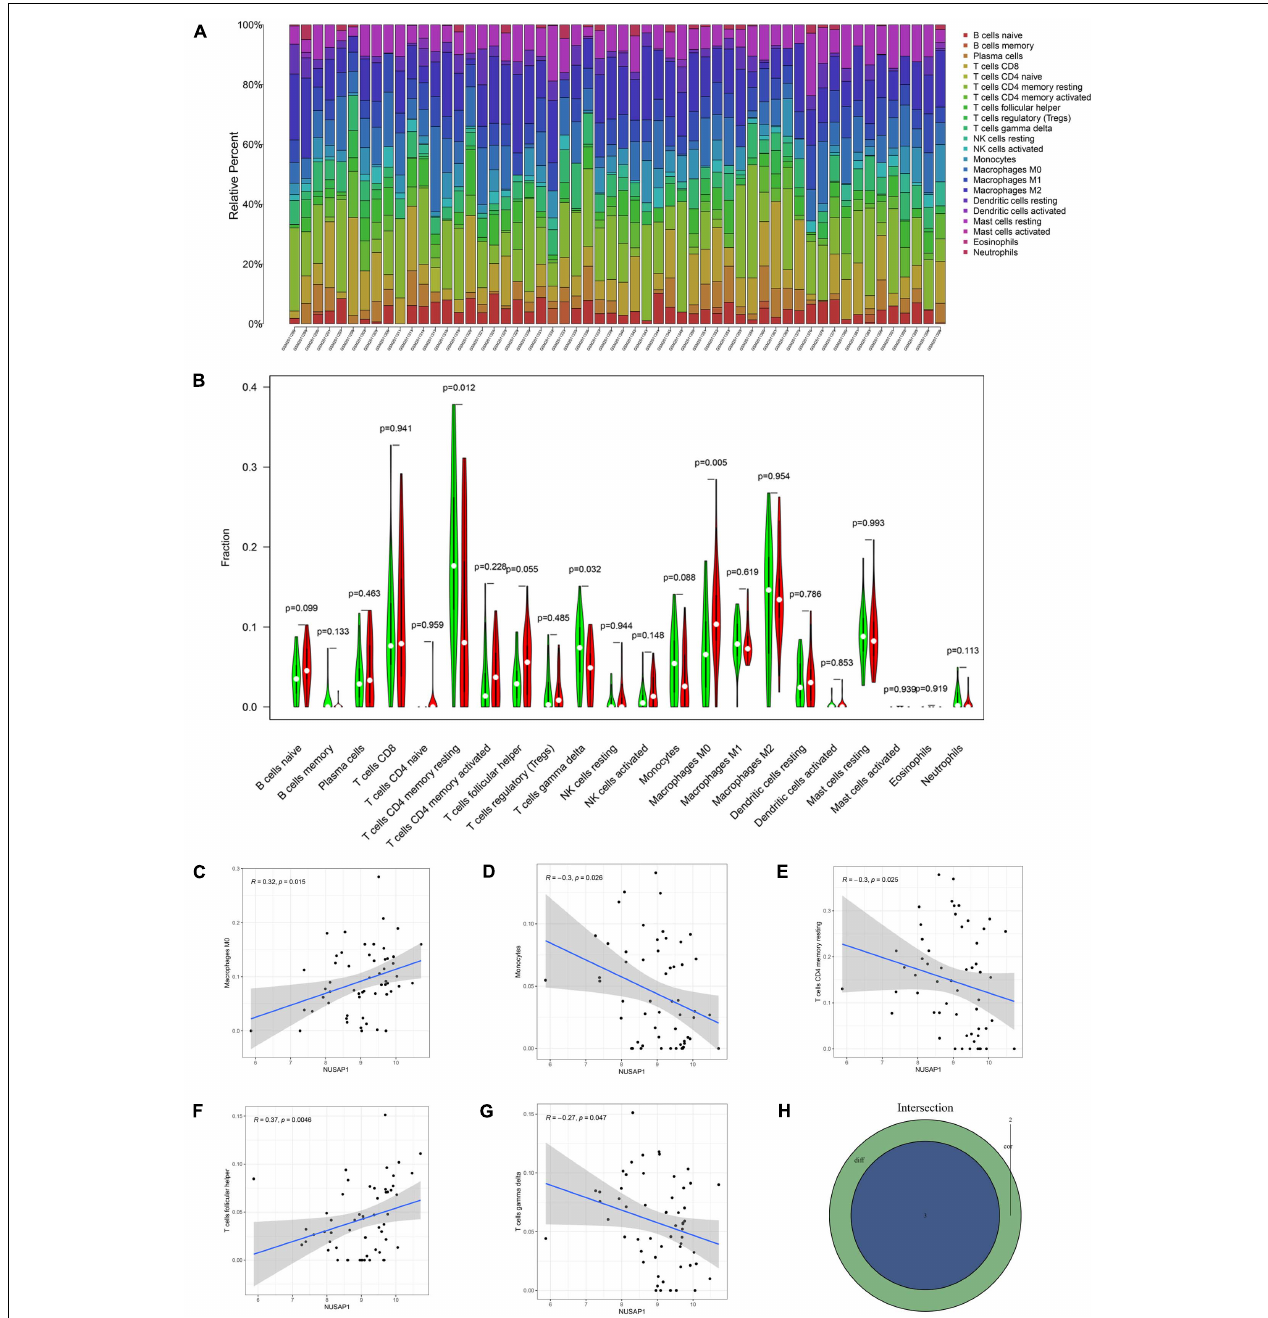
FIGURE 9 | Bar plot, violin plot, correlation diagrams, and Venn diagram. All pictures were drawn by HCC patients’ information in GSE76427 dataset. (A) Bar graph, which contained content of 22 immune cells in each sample. (B) Violin plot, which proved 22 immune cells whether they exhibited difference between high expression group and low expression group. (C) The correlation diagram between NUSAP1 and macrophages M0. (D) The correlation diagram between NUSAP1 and monocytes. (E) The correlation diagram between NUSAP1 and T cells CD4 memory resting. (F) The correlation diagram between NUSAP1 and T cells follicular helper. (G) The correlation diagram between NUSAP1 and T cells gamma delta. (H) Venn diagram, which was used to visualize the immune cells that were both meaningful in violin plot and correlation diagrams.